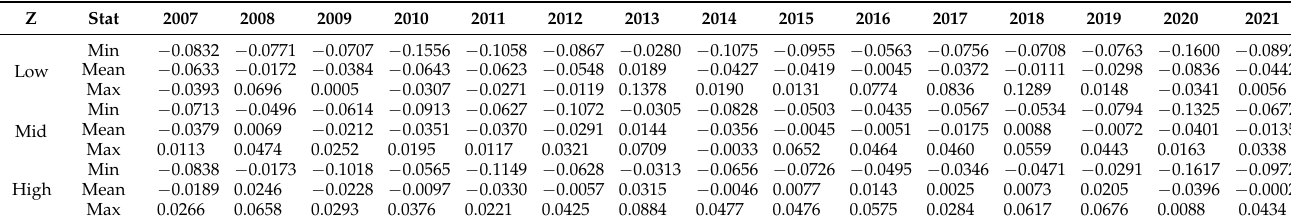
Table 5. Minimum, mean, and maximum NDII values from 2007 to